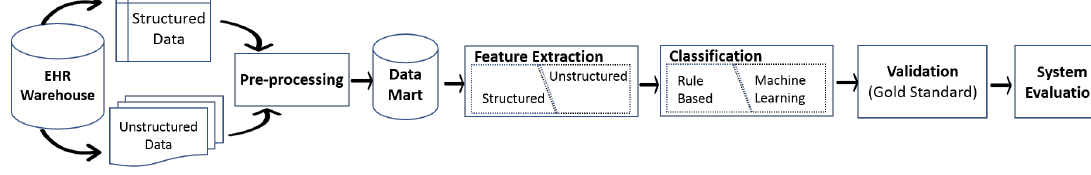
Figure 1. General model of automatic phenotyping